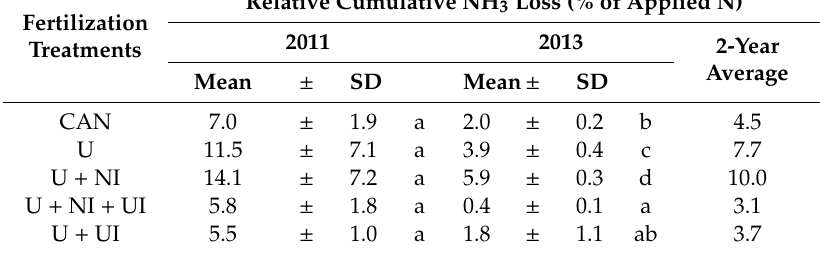
Table 6. Relative cumulative NH 3 -N losses (% of applied N; Mean ± SD) of di ff erent fertilization treatments (CAN: calcium ammonium nitrate; U: urea; NI: nitrification inhibitor; and UI: urease inhibitor) during 2011 and 2013. A mean comparison between fertilization treatments from Tukey´s HSD-test with di ff erent letters indicates a significant di ff erence at p < 0.05. The same letters in the same column indicate groups that were not significantly di ff erent from one another. Relative Cumulative NH 3 Loss (% of Applied Fertilization Treatments